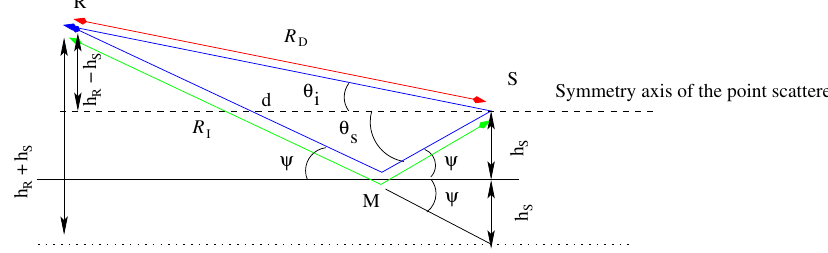
Figure 2. Direct (red), Direct-Indirect and Indirect-Direct (blue), Indirect (green) paths and associated